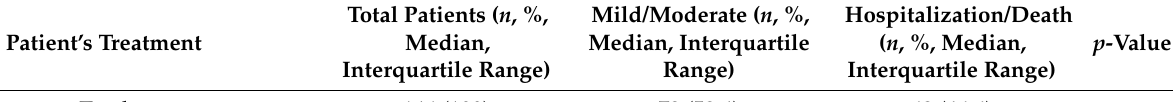
Table 5. Treatments with macrolides and concomitant treatmentsin patients with COVID-19 by